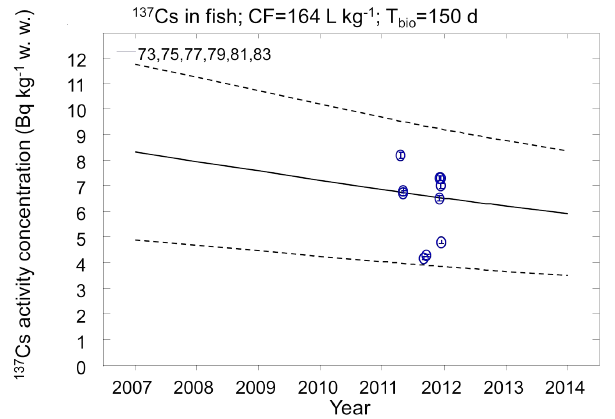
Fig. 2. Curves of 137 Cs activity per unit mass in fish using the two- compartment fish model, volume-averaged over the surface boxes 75, 81 and 83 and their associated bottom-layer boxes, and mea- sured values (circles) of 137 Cs in BS fish. Individual measured val- ues are given with ± 2 σ bars; the dashed lines represent the 95% confidence curves of the model (see text).